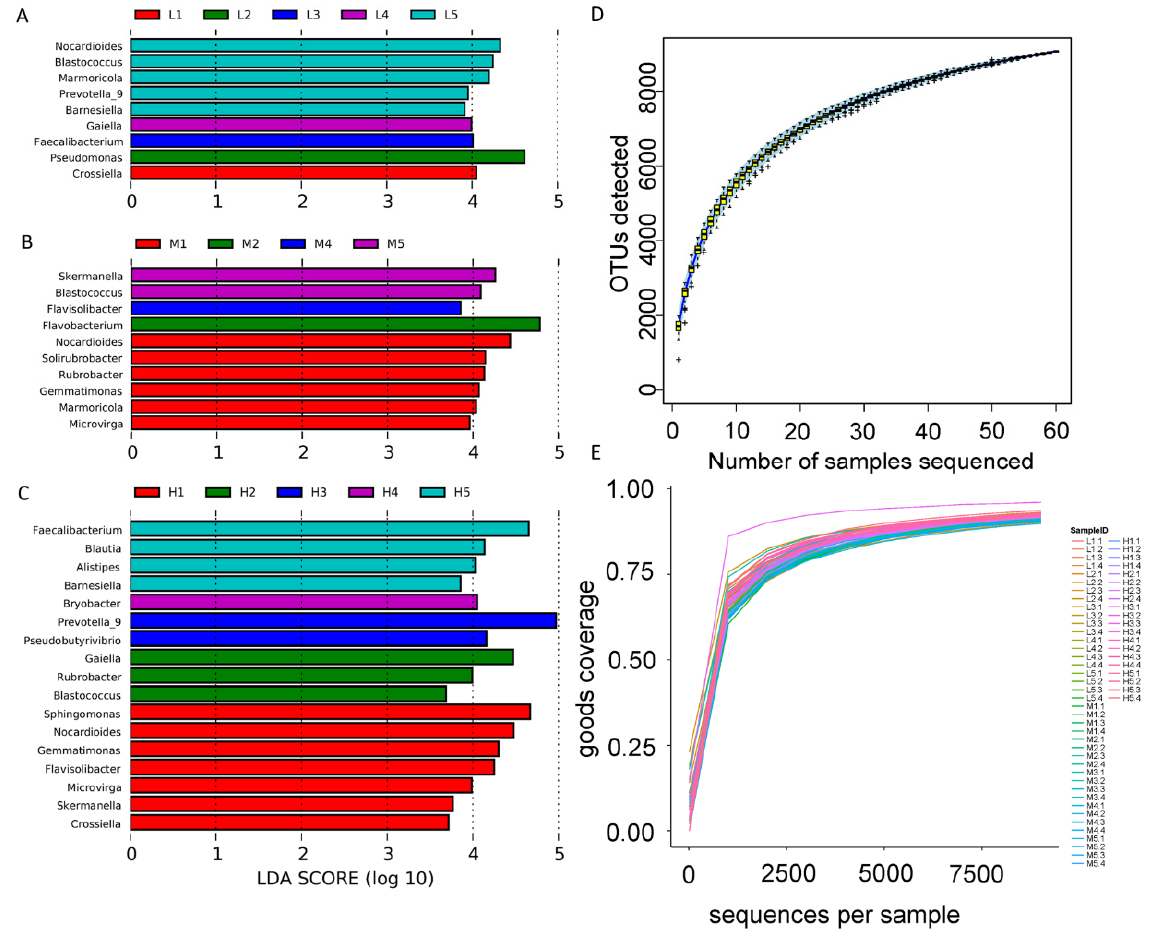
Figure 8. Linear discriminant analysis (LDA) of soil bacterial community in 3 sites of ( A ) 4000 m, ( B ) 4600 m, and ( C ) 5200 m. Rarefaction curve ( D ) and species accumulation curves ( E ) of the 60 soil samples.